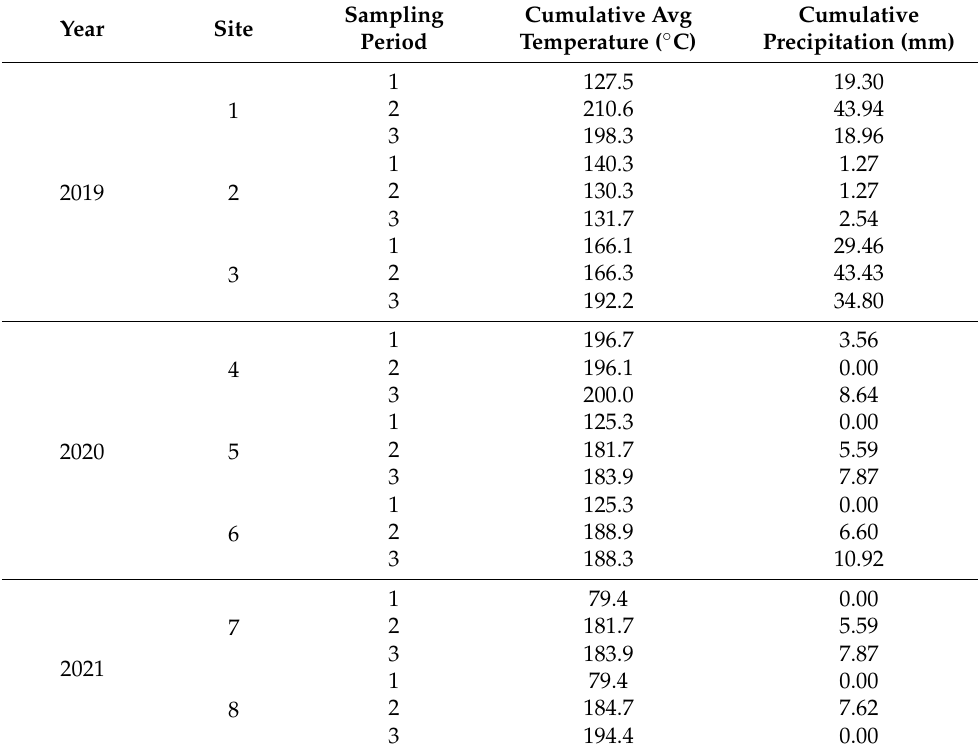
Table A1. Cumulative average temperature (°C) and cumulative precipitation (mm) before any insecticide application (sampling period 1), at the tank mix application (sampling period 2), and at late insecticide application (sampling period 3) per site and year.